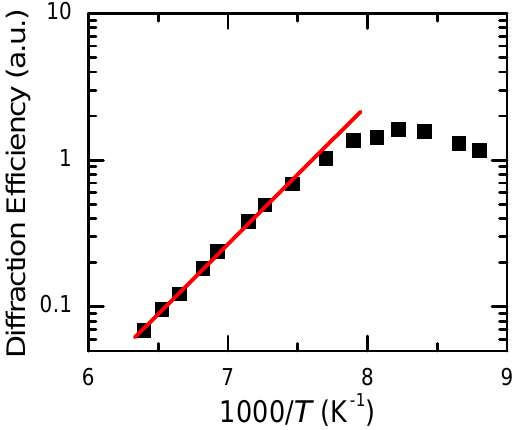
Figure 16. Temperature dependency of diffraction efficiency of the hologram recorded in :In ( N = 2 × 10 18 cm − 3 ) crystal by argon laser radiation ( λ = 514 CdF 2 In